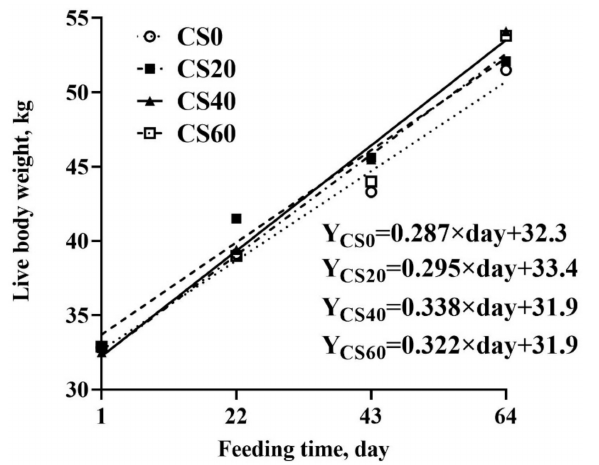
Figure 1. Effect of dietary CS addition on live body weight of feedlot lambs (CS0, control group; CS20, 20 mg/kg BW; CS40, 40 mg/kg BW, CS60, 60 mg/kg